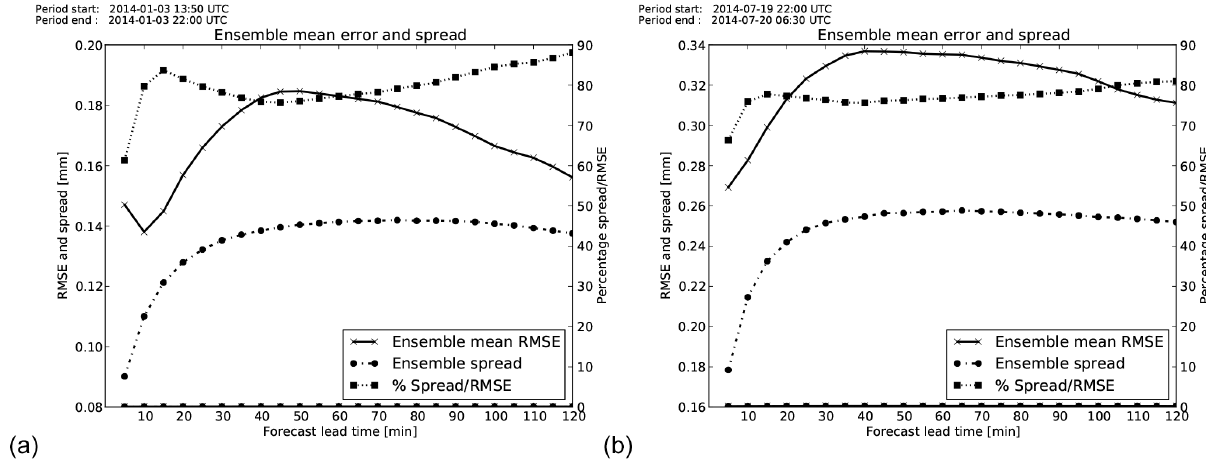
Figure 9. Comparison of ensemble spread and RMSE of the ensemble mean forecast at 5min resolution for (a) the Ghent case on 3 January 2014 and (b) the Leuven case on 19–20 July 2014.